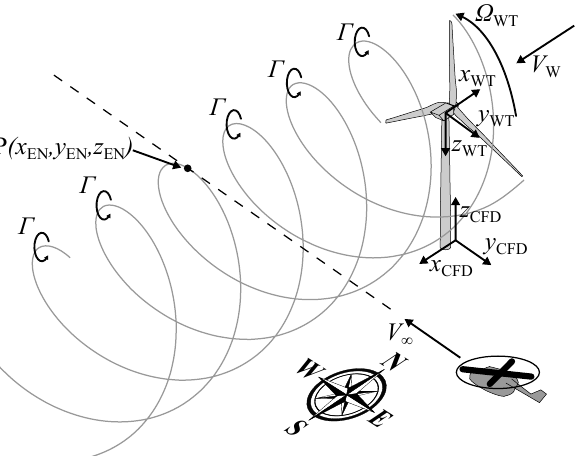
Figure 2. Operational Scenario 1 (OS-1): Transit flight with direction west next to a rotating WT. Operational Scenario 2 (OS-2) describes a hover flight at a non-rotating WT (Figure 3) and was used to examine the lateral safety clearance at the helicopter hoist area (Figure